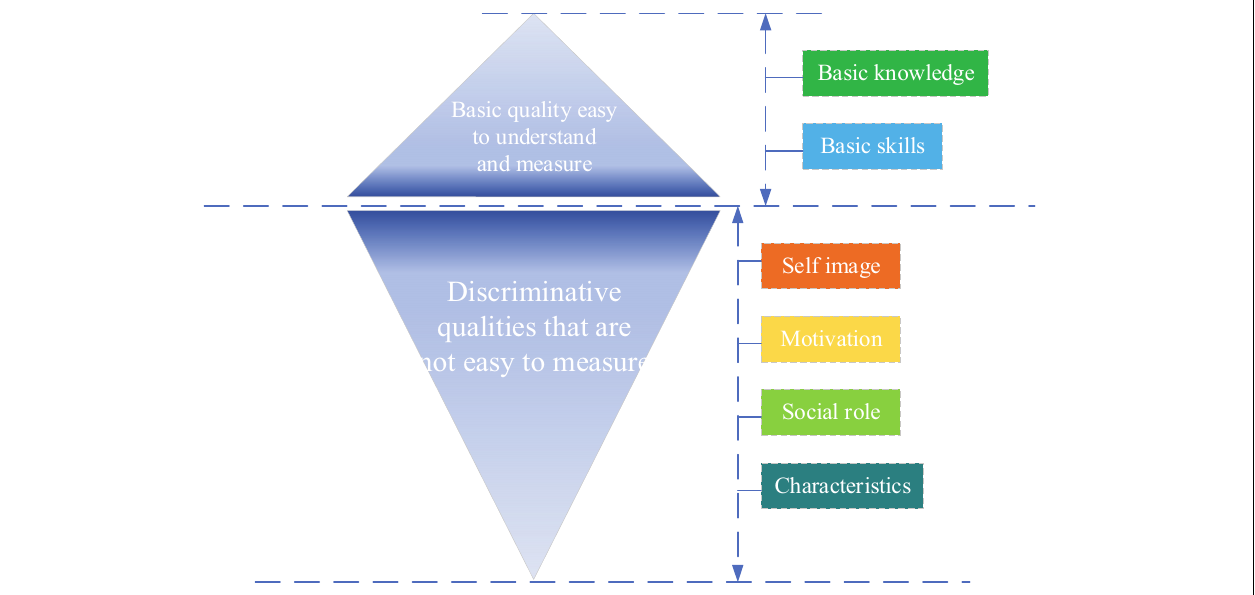
failure of new ventures. Psychological characteristics of new entrepreneurs are shown in Figure 2 .